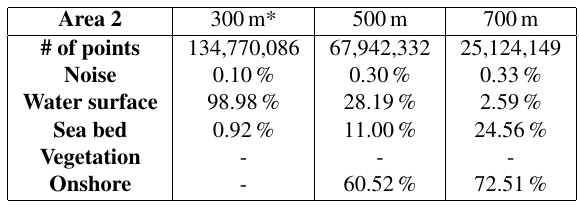
Table 3: Distribution of classes in Area 2 (* area obtained with 300m altitude is smaller).